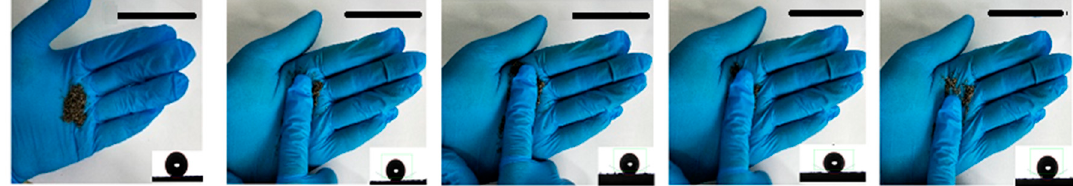
Figure 7. The finger wiping test after 0 (WCA: 155.3°), 20 (WCA: 155.4°), 40 (WCA: 154.9°), 60 (WCA: 153.0°), 80 (WCA: 151.0°) cycles. Scale bar, 5 cm.